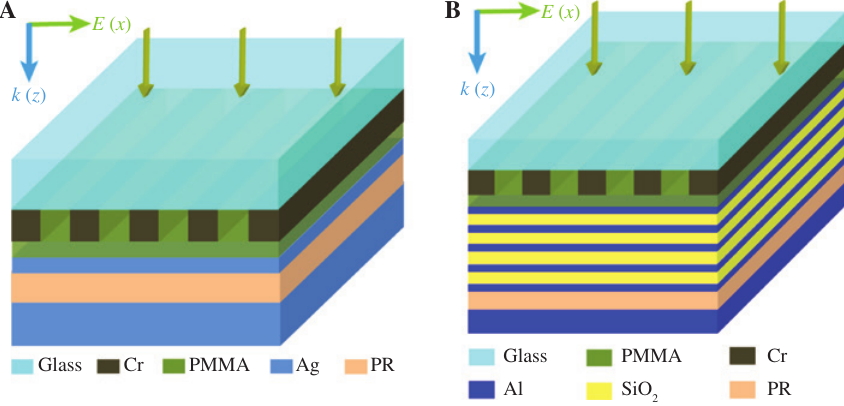
Figure 1: Schematics of plasmonic lithography based on the (A) superlens structure and (B) HMM